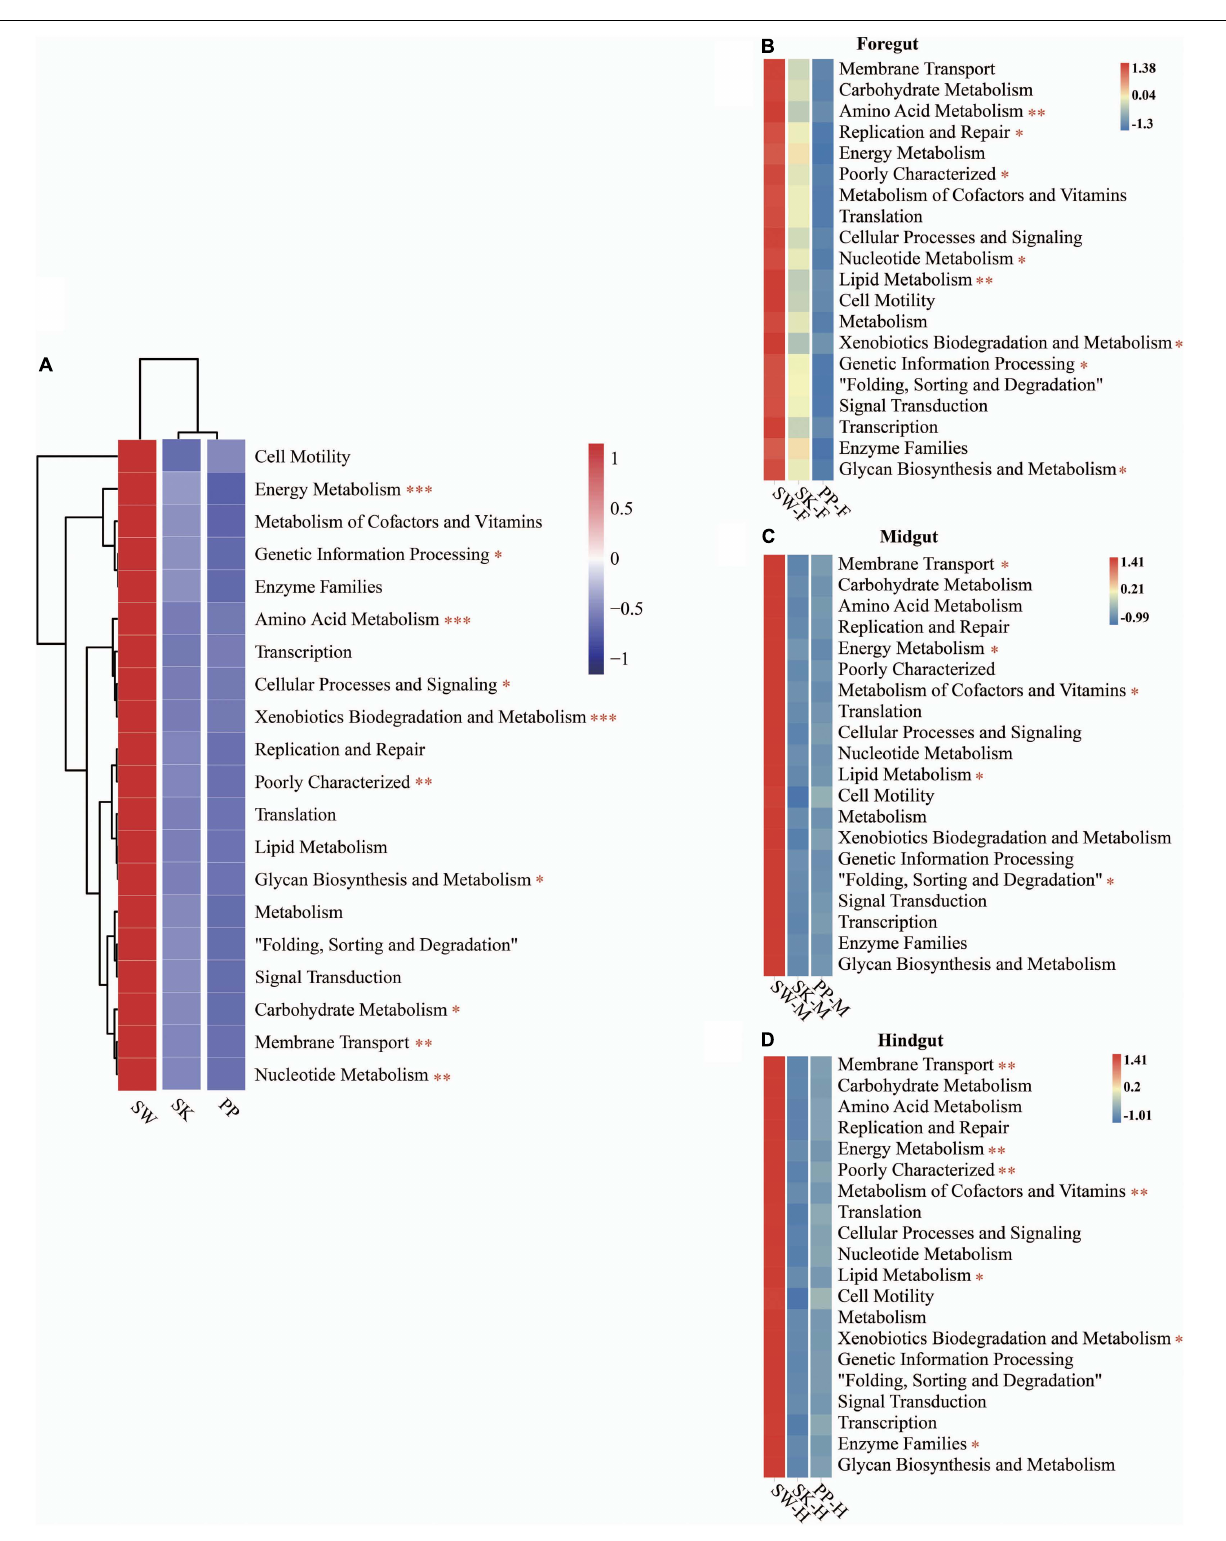
Frontiers in Microbiology |